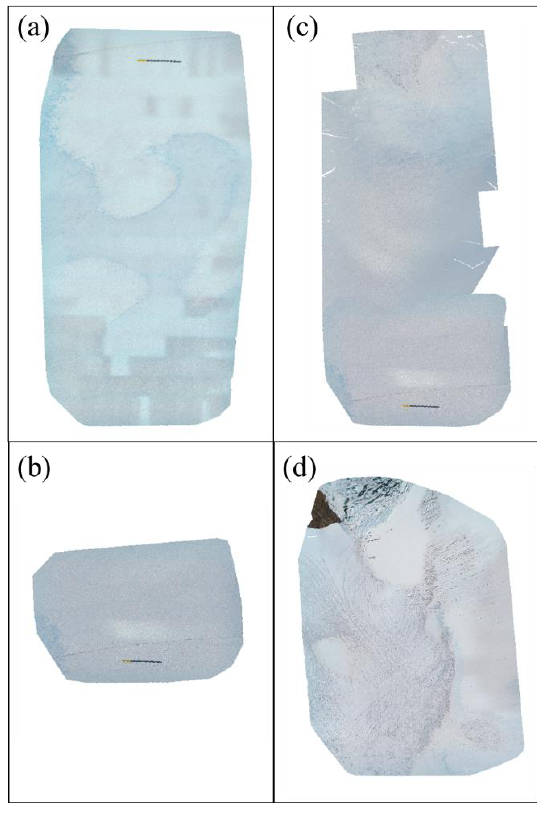
Figure 2 . UAV Derived DSM